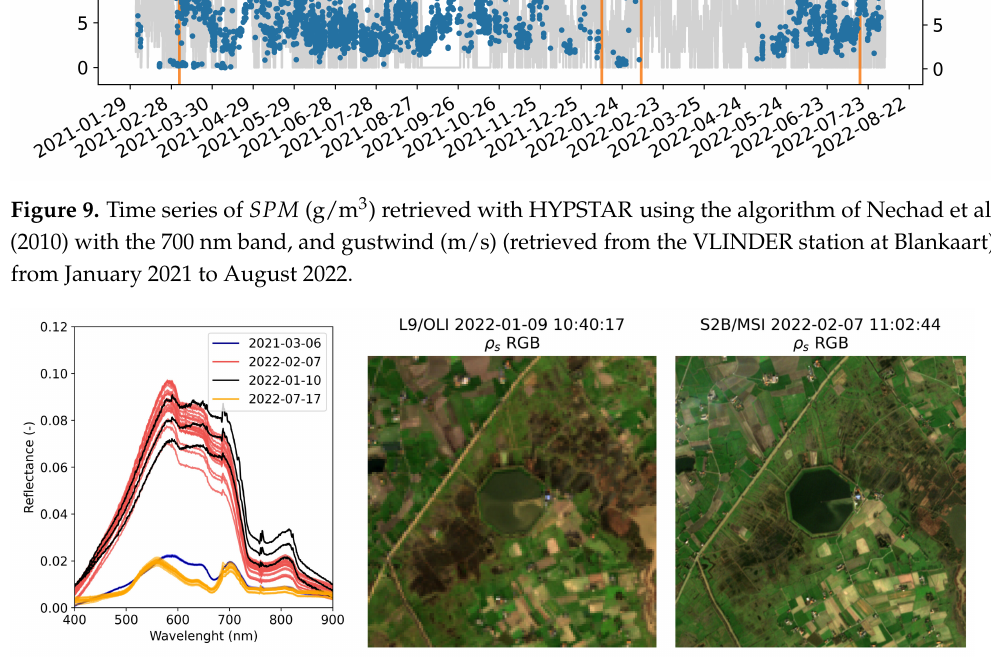
Figure 10. Spectra for the different dates given with the orange vertical bars in Figures 7 and 9 and Landsat-9 OLI RGB image and Sentinel-2B MSI RGB image processed with ACOLITE [23] taken on 2022-01-09 and 2022-02-07,